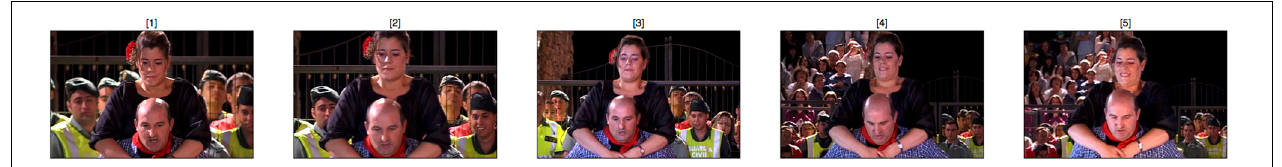
FIGURE 2 | Presentation of a typical sequence of rated images. Raters were from the geo-cultural region in which the fire-walk took place, but had never attended. The sequence of images was presented in the order in which the ritual occurred. Raters were given a brief description of the ritual. We recruited raters from the